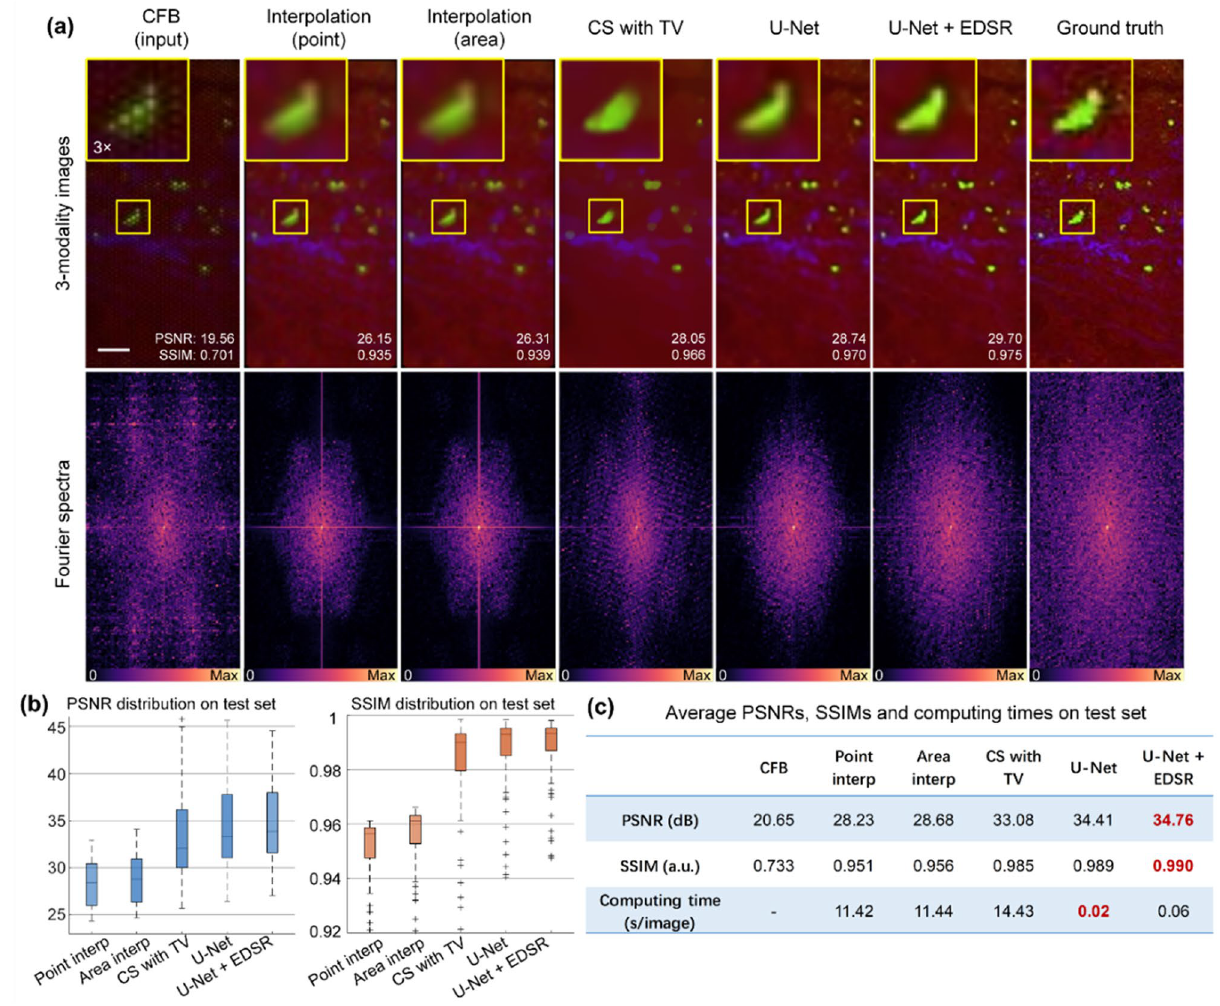
Figure 3. Image enhancement for the synthetic CFB images. ( a ) Comparison of enhanced images with ground truth by different methods in spatial and frequency domain. Scale bar: 20 μm. ( b ) Quantitative evaluation of the image quality of different methods in terms of PSNR and SSIM. Box plot: center line, median; box limits, upper and lower quartiles; whiskers, 1.5 × interquartile range; plus sign, outliers. ( c ) Average PSNRs, SSIMs and computing times of different methods. The U-Net + EDSR provides best image quality and fast